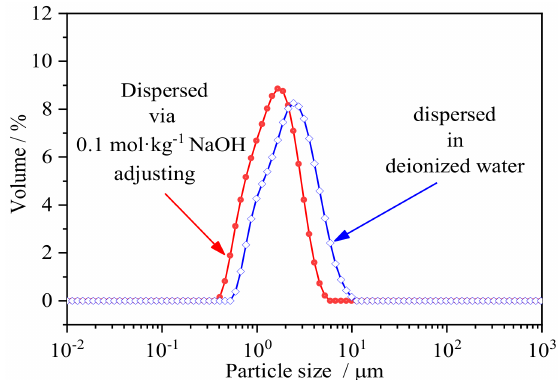
Figure 3. Particle size distribution of IREO colloids in the suspension before and after 0.1 mol · kg − 1 NaCl